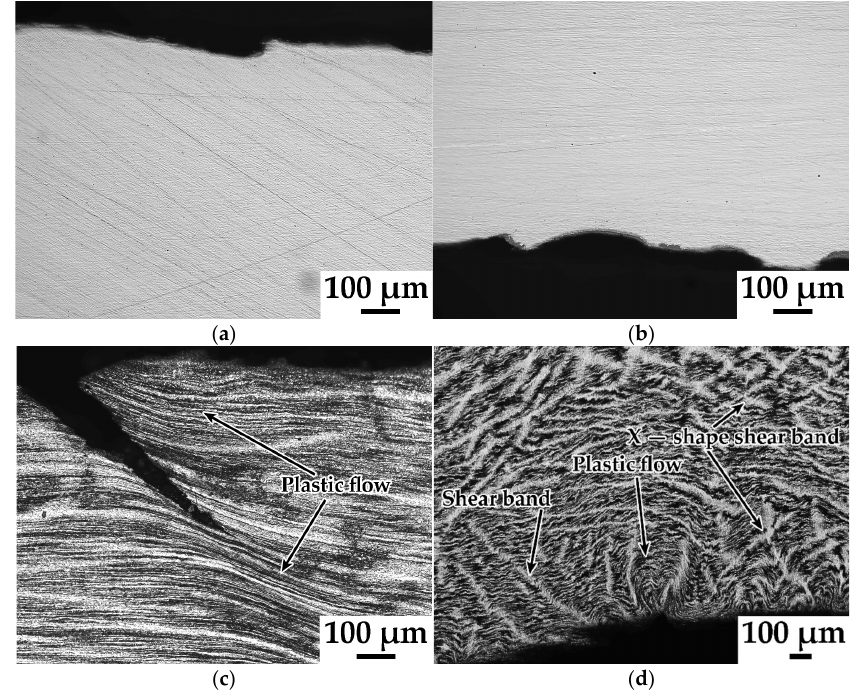
Figure 3. The OM images of the 5% Ni steel sample surfaces: ( a ) outer arc and ( b ) inner arc surfaces before bending, and ( c ) outer arc and ( d ) inner arc surfaces after bending.